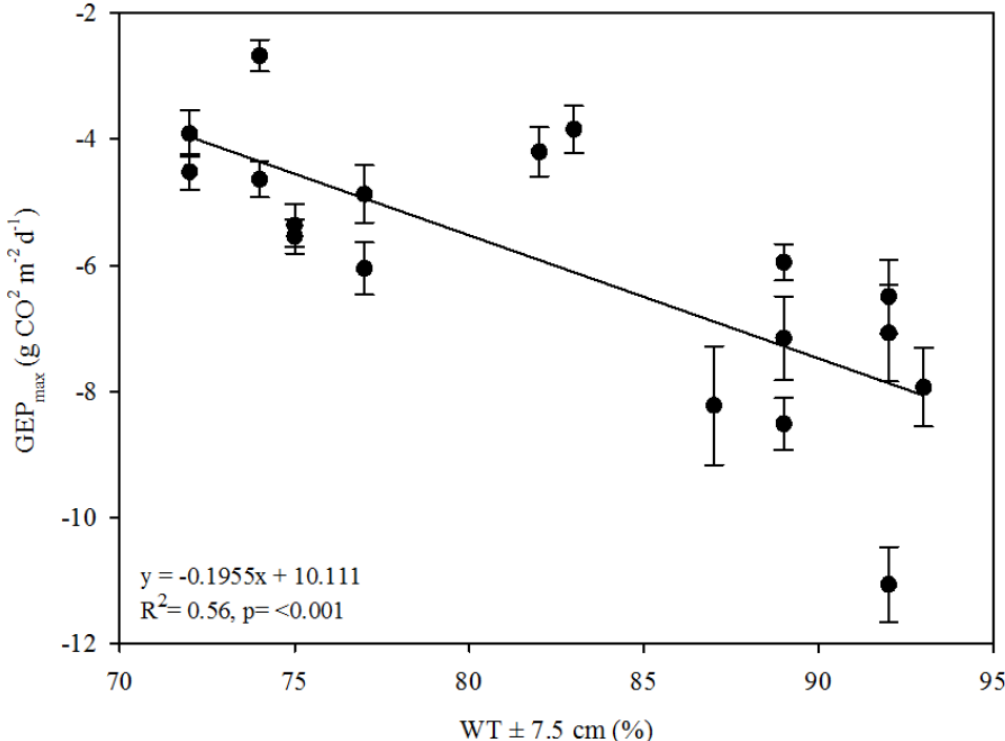
Figure 4. Year 2 mean plot gross ecosystem photosynthesis when photon flux density of photosynthesis was greater than 1000 µmol m-2 s-1 (GEP ) and optimal range days (ORD), which is the number of thawed max days in the growing season that the WT remained ± 7.5 cm from the seasonal mean. The control was not included because data collection does not represent the start of the growing season. LA20-1 and LA20-2 were not included because they were the only two plots that decreased in cover, and this is attributed to inundation in Year 1 or measurement